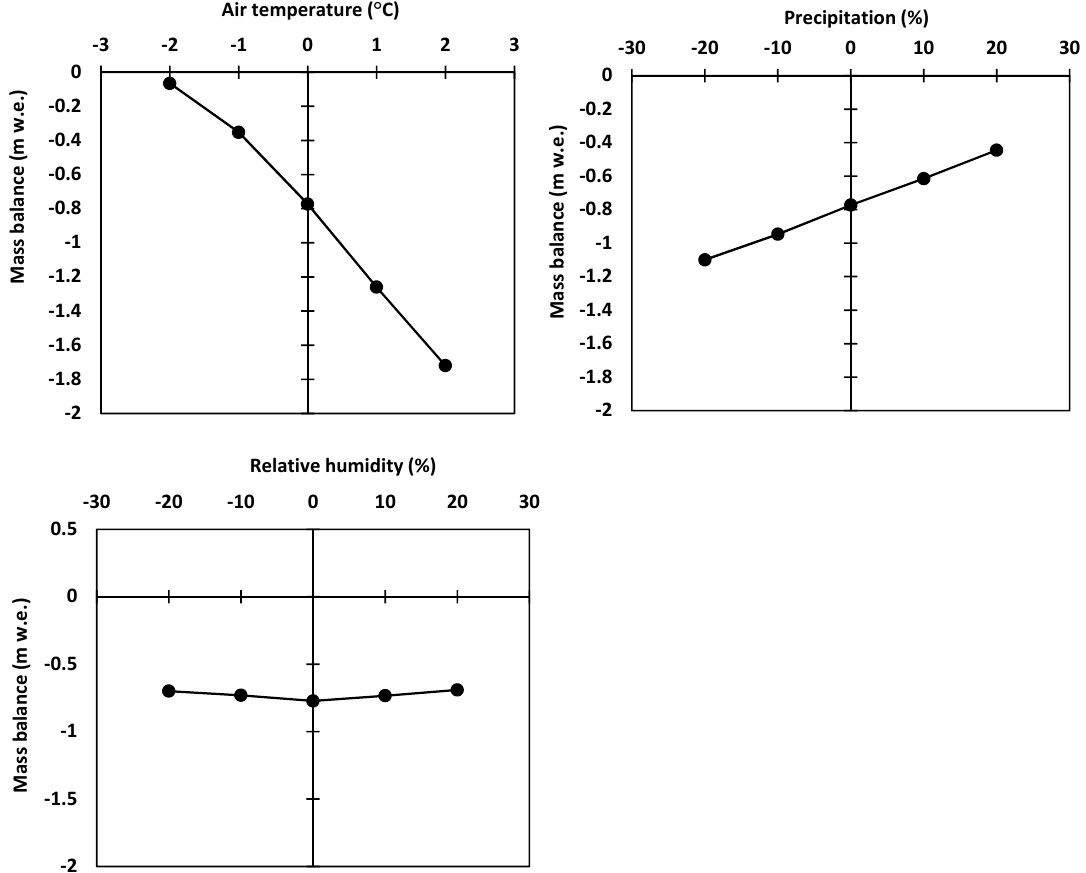
Figure 5. Sensitivity test of mass balance to the input variables; air temperature, precipitation, and relative humidity. Table 6. Results of sensitivity analysis of the model for the period of 5 May 2014–15 November 2014.